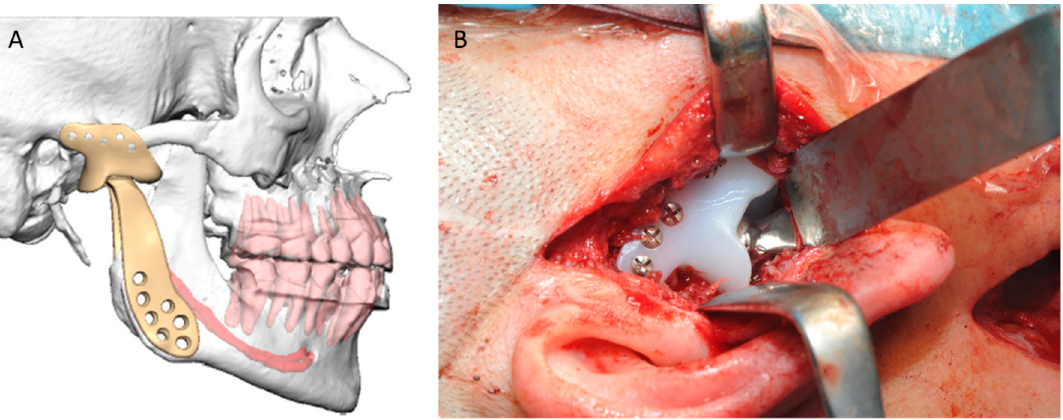
Figure 10. 3D-based TJR. VSP ( A ) and intraoperative placement of the patient-specific implant to the mandible and fossa ( B ).